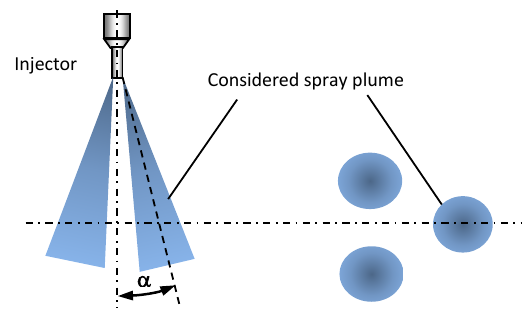
Figure 6. Jet inclination angle, α definition.